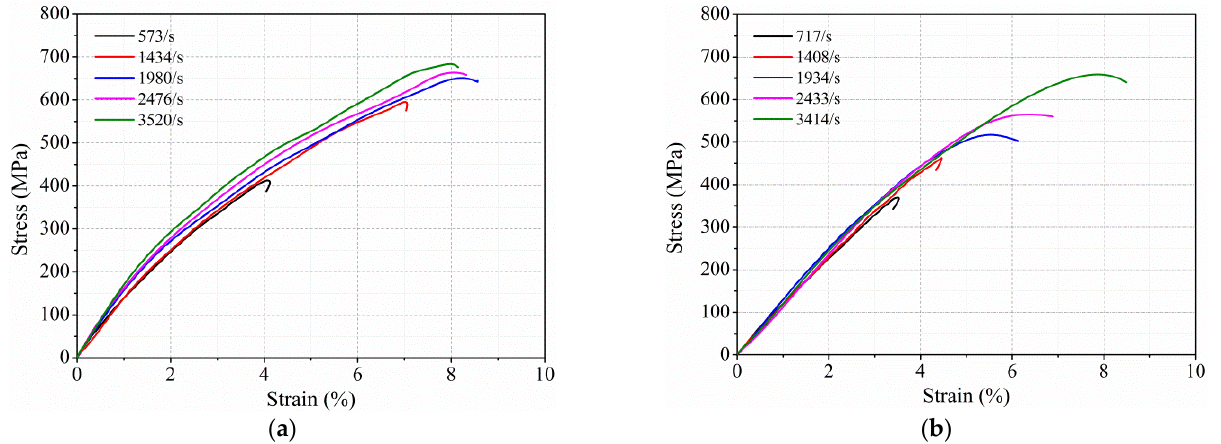
Figure 4. Stress–strain curves of composites under out-of-plane loading at room temperature (RT). ( a ) GF/PPS and ( b ) CF/PPS specimens.